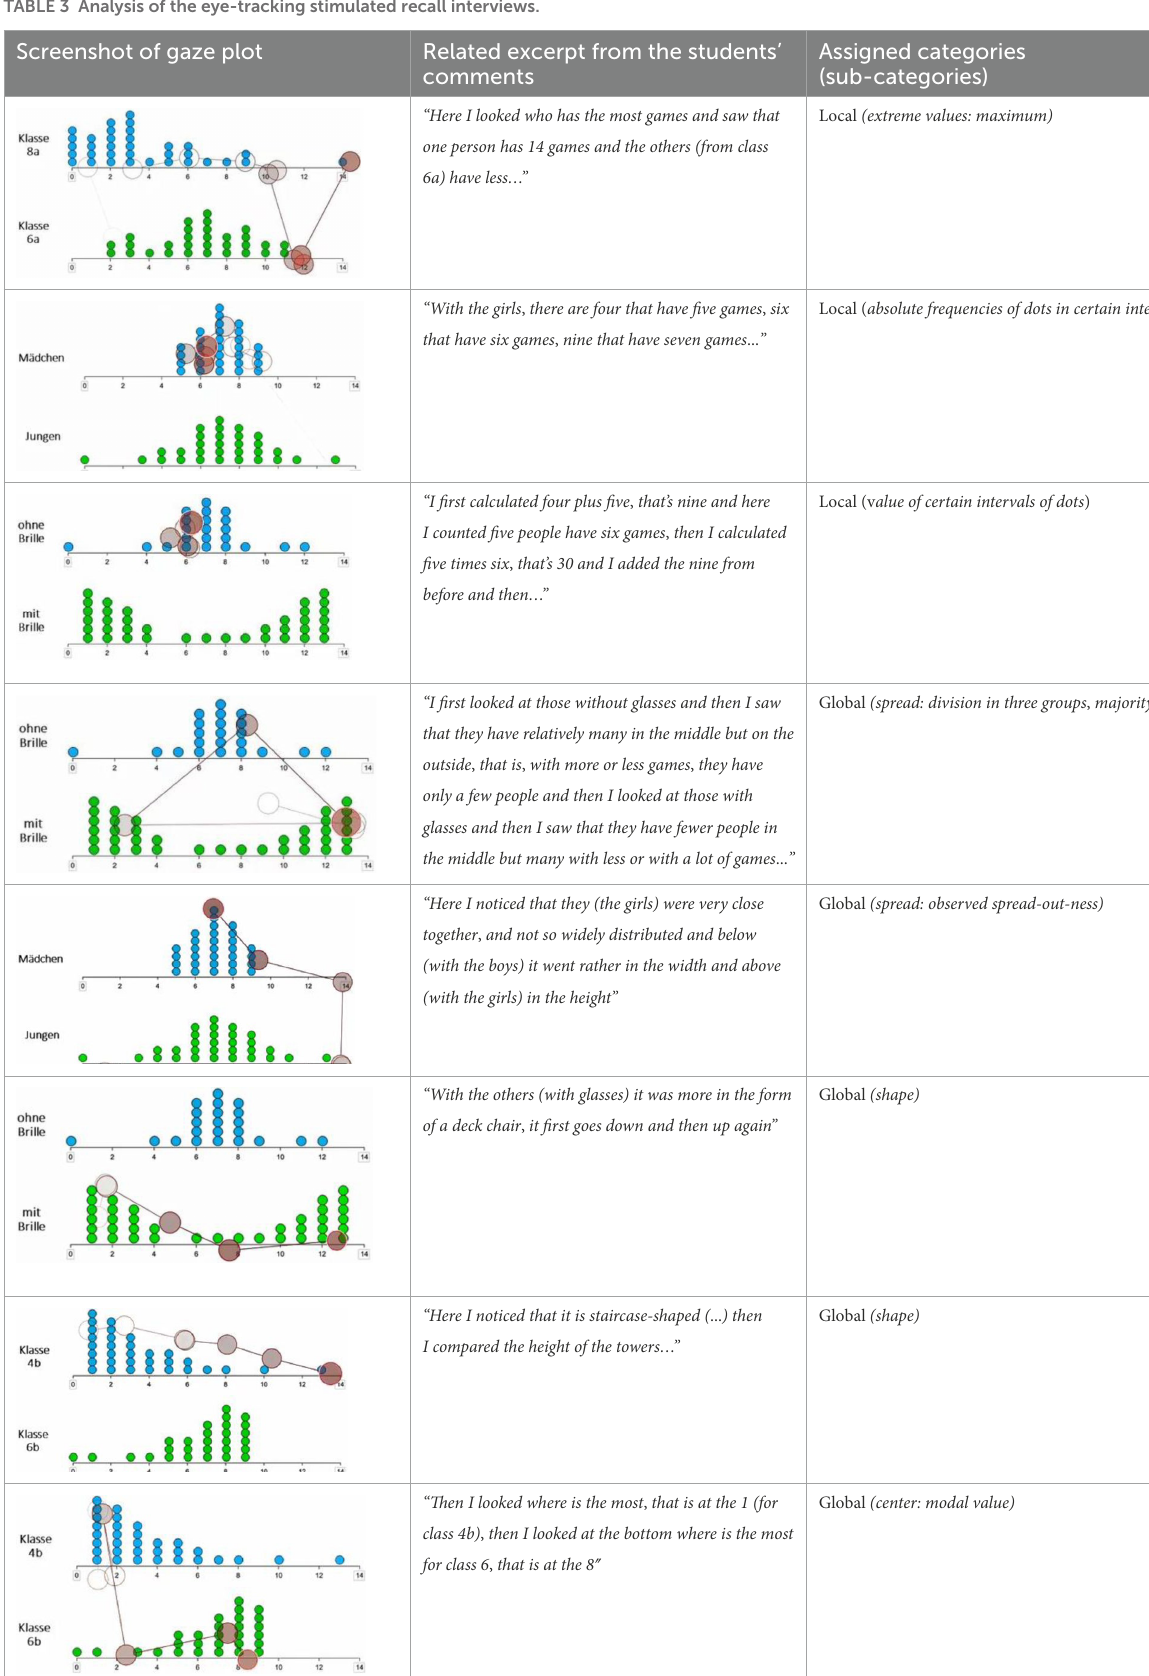
TABLE 3 Analysis of the eye-tracking stimulated recall